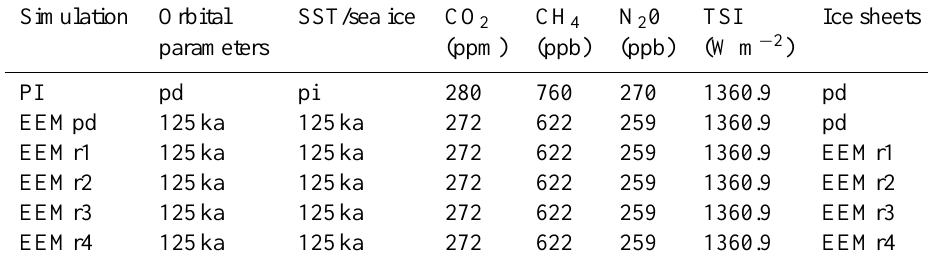
Table 1. List of model simulations and the forcing used in the experiments. Present-day levels are denoted as pd, pre-industrial levels as pi. The orbital parameters are calculated according to Berger (1978). SST and sea ice fields are outcomes of corresponding fully coupled CCSM3 simulations (see Sect. 2.1 for details). Solar forcing is expressed as total solar irradiance (TSI) and corresponds to the CCSM4 standard pre-industrial level. The set of implemented ice sheet topographies is shown in Figs. 2 and